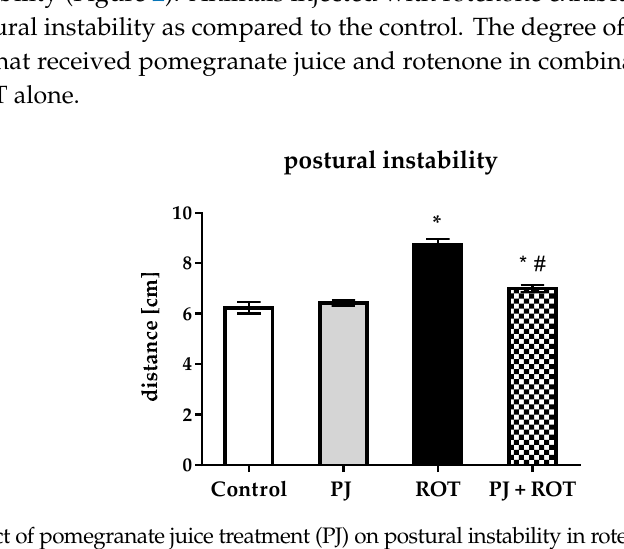
Figure 2. Effect of pomegranate juice treatment (PJ) on postural instability in rotenone (ROT)-injected rats. Data are presented as mean values ±SEM of eight rats per group and analyzed using one-way analysis of variance (ANOVA) followed by Sidak’s multiple comparisons. * p < 0.05 vs. Control. # p < 0.05 vs. ROT.